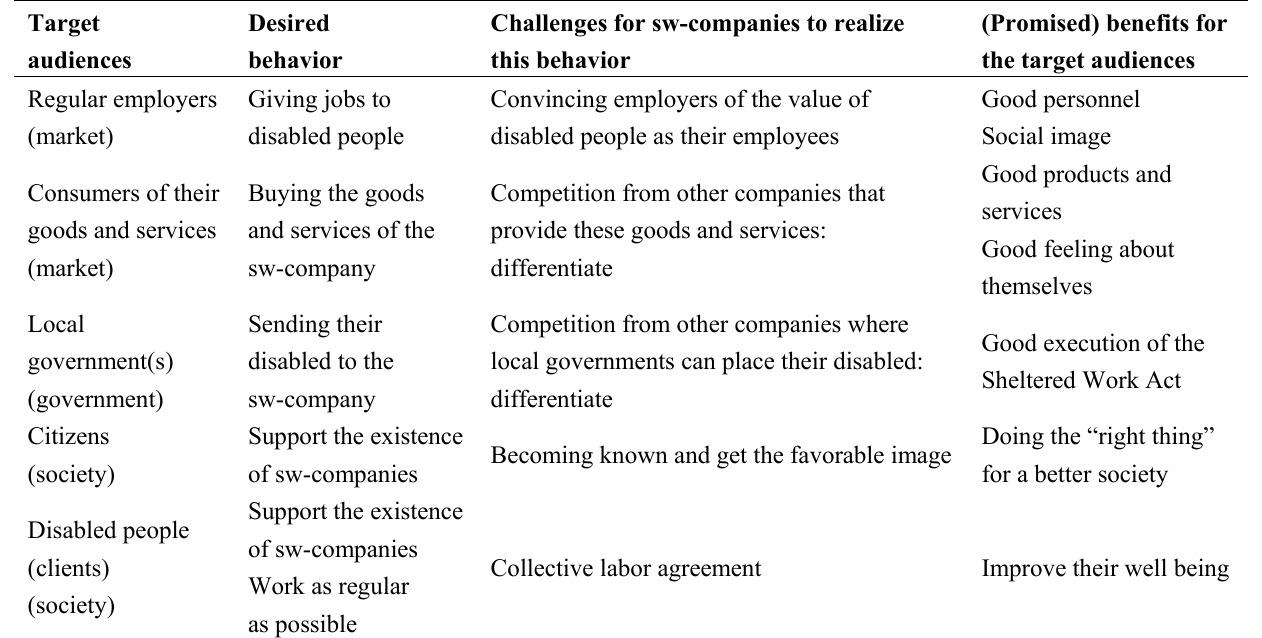
Table 1. The target audiences, their desired behavior for sw-companies, and benefits. Target